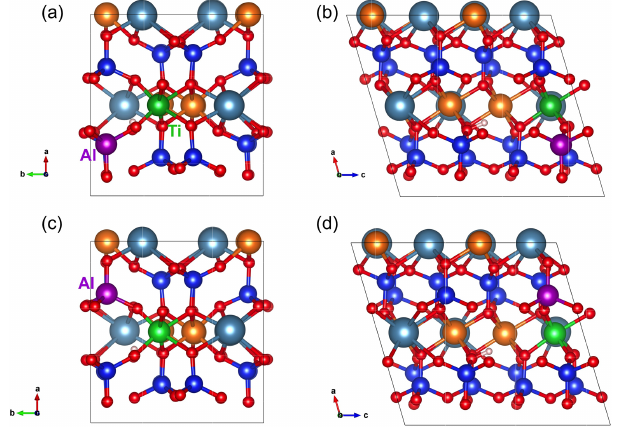
Figure 4. (a,b) Structure of [(2H + ) M2 (Ti 4 + ) M1 (Al 3 + ) Si ] × _a defect in diopside viewed along the [001] (a) and [010] (b) directions (model 17, Table 1). (c, d) Structure of [(2H + ) M2 (Ti 4 + ) M1 (Al 3 + ) Si ] × _b defect in diopside viewed along the [001] (c) and [010] (d) directions (model 18, Table 1). Atom colors are the same as in Fig.